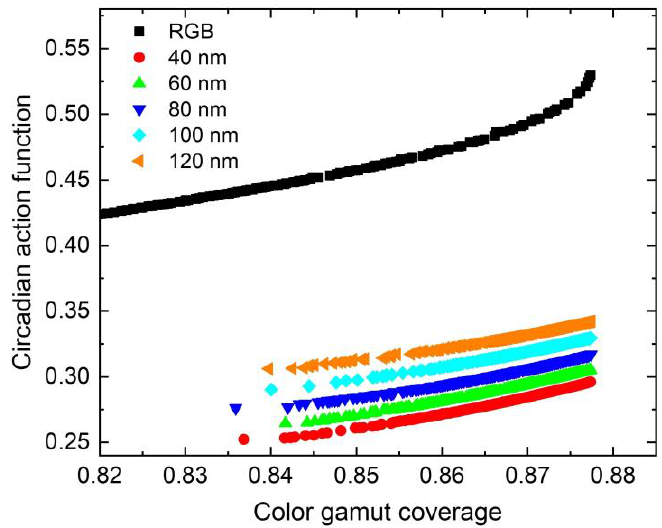
Figure 4. Pareto front of red, green, blue, and white (RGBW)-type micro-LED displays.